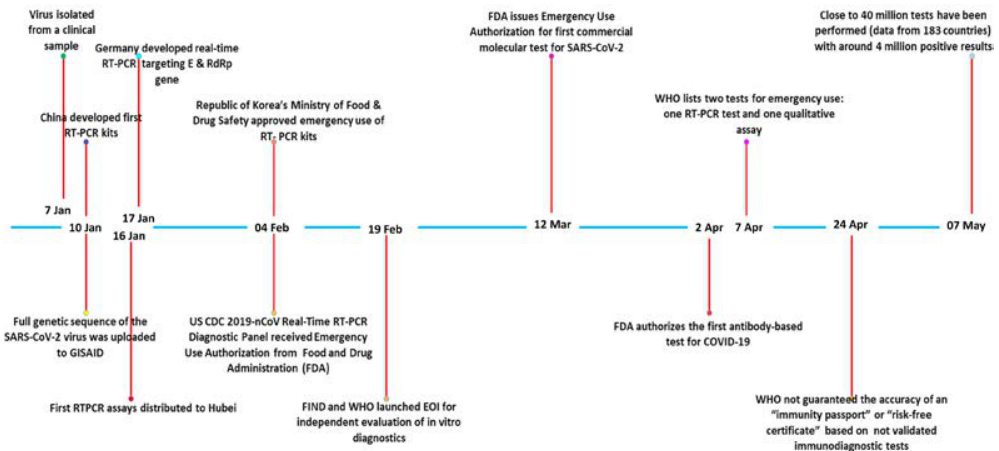
Fig. 1. Timeline of COVID-19 diagnostics response and development of